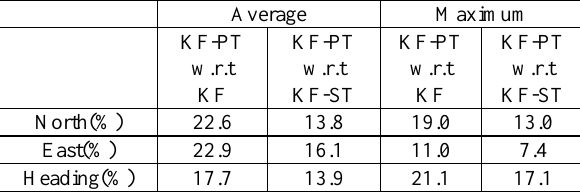
Table 3. Position and Heading Improvement Compared to KF and KF-ST